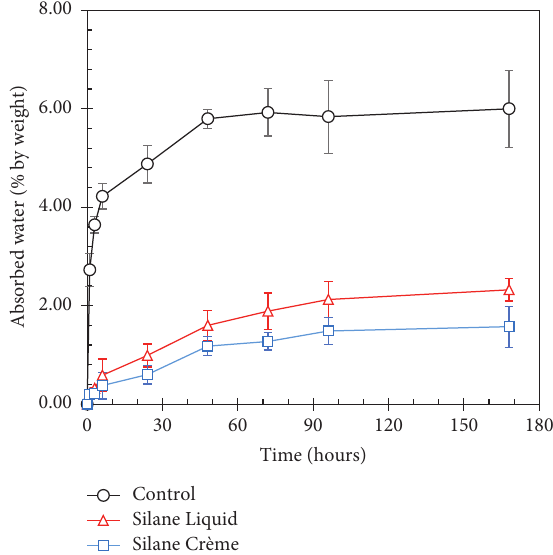
Figure 4: Water absorption of concrete at surface treatment of SS liquid and SS cr`eme.